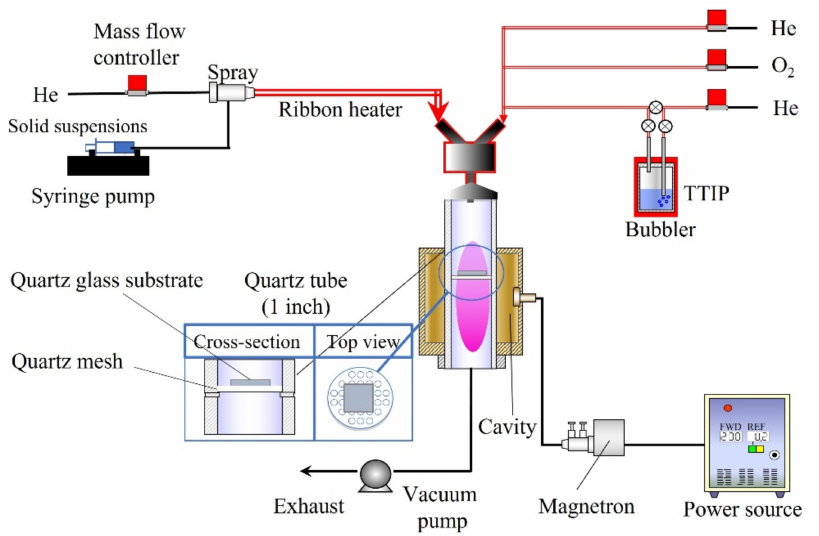
Figure 12. Experimental setup for